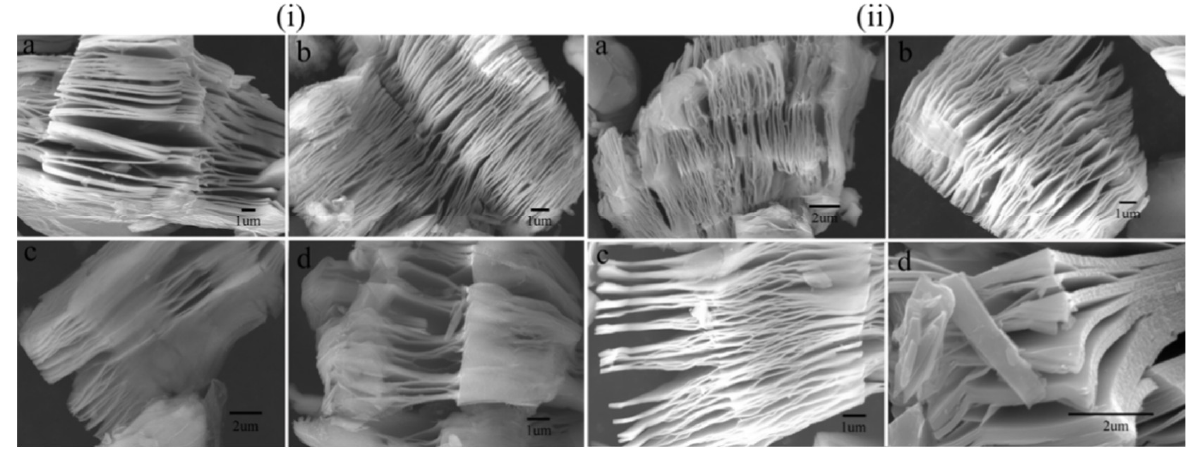
Figure 3. SEM micrograph of exfoliated MXene ( i ) (Ti 3 C 2 ) with ( a ) LiF ( b )NaF, ( c ) KF ( d ) NH 4 F, in HCl, and ( ii ) (Ti 2 C) with ( a ) LiF ( b )NaF, ( c ) KF ( d ) NH4F, in HCl. Reproduced with permission from [47] Copyright (2017) Elsevier.